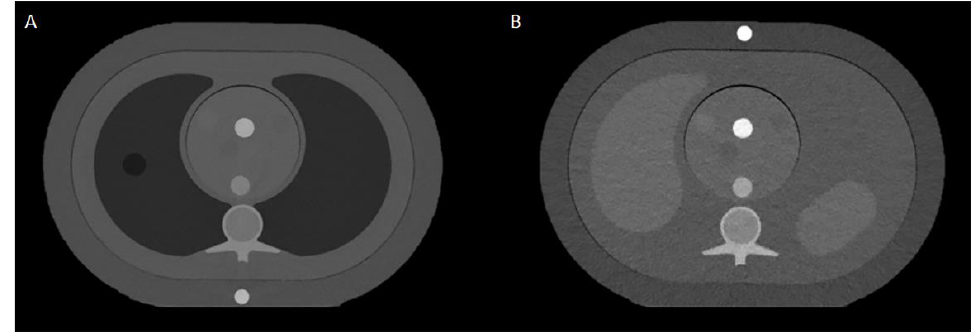
Figure 1. CT Images of the thoracic ( A ) and the abdominal ( B ) phantom with the medium size extension ring and the insert containing the iodine and water tubes.